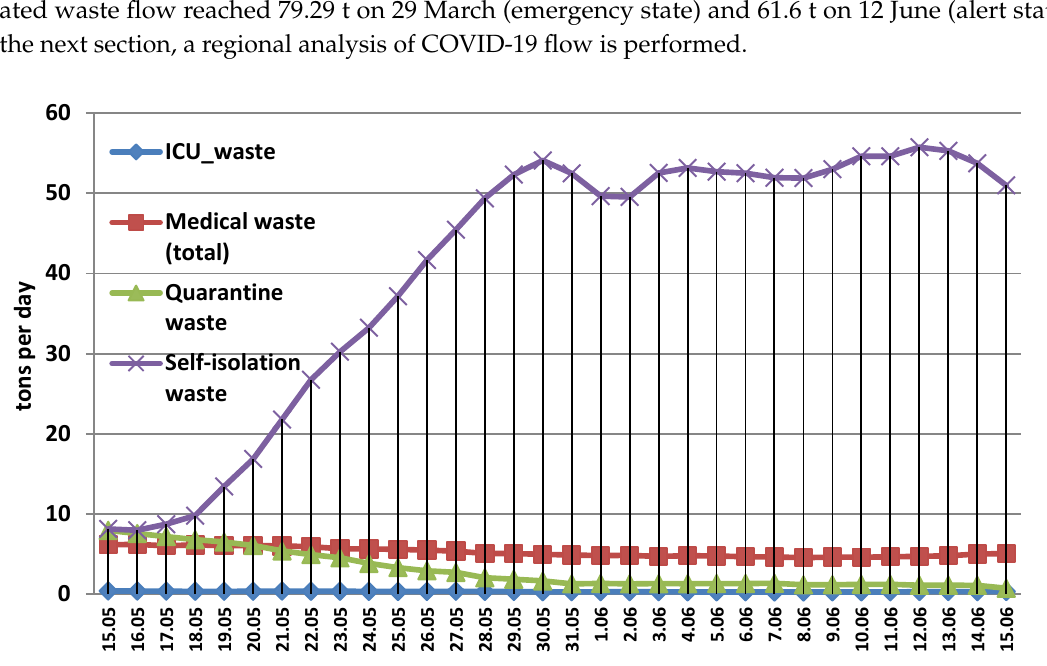
Figure 2. COVID-19 related waste flow in Romania during the alert state.